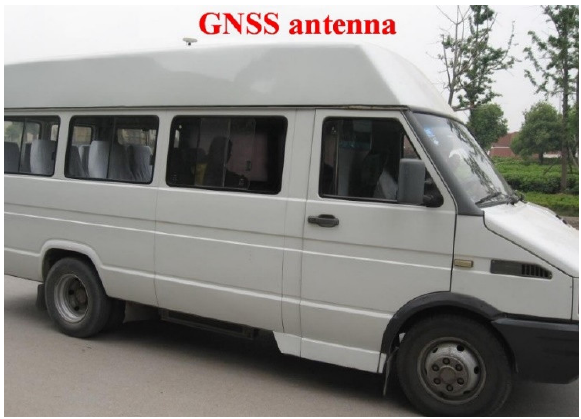
Figure 3. The test vehicle platform.